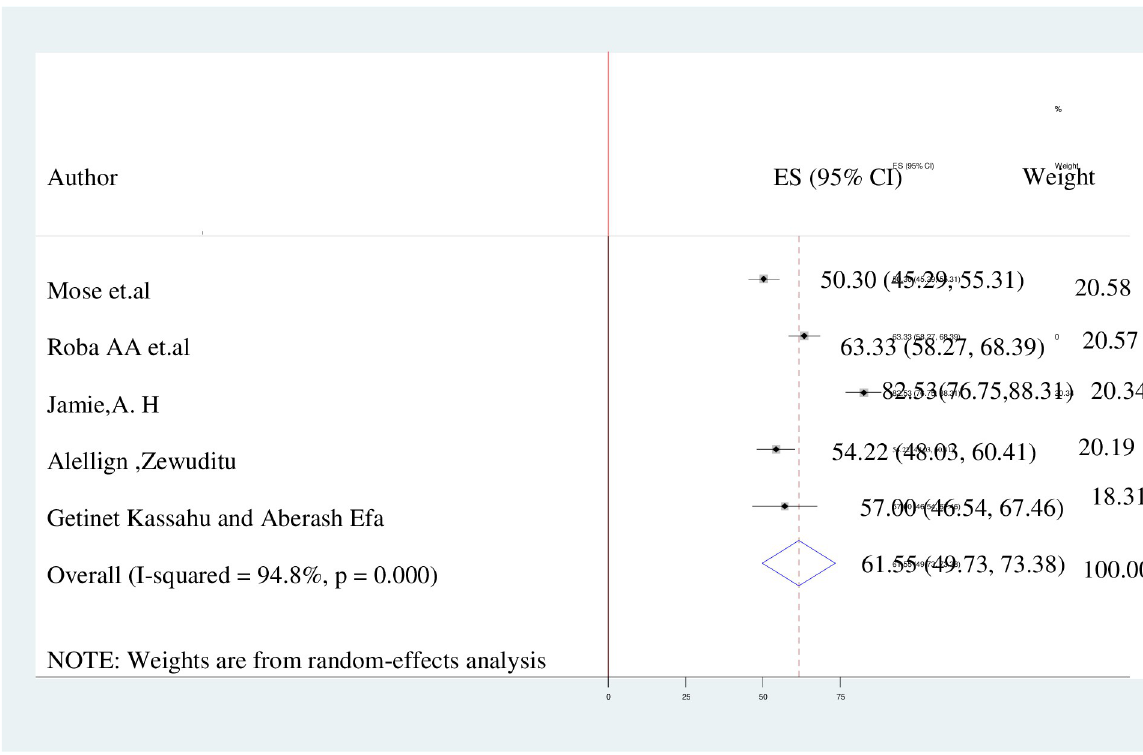
Fig 3. The forest plot of attitude with the diamond represents the summary point estimate (61.55%) and the horizontal extremity of the diamond is the confidence interval at 95% (49.73%–73.38). The standard error is plotted at the y-axis and the effect size plotted at x-axis. The squares represent the effect estimate of the individual studies and the horizontal lines indicate the confidence interval; the dimension of the square reflects the weight of each study.